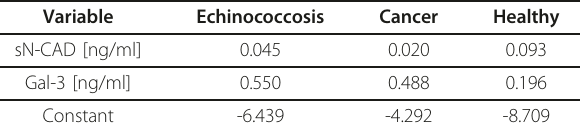
Table 2 Classification function coefficients determined using discriminant function